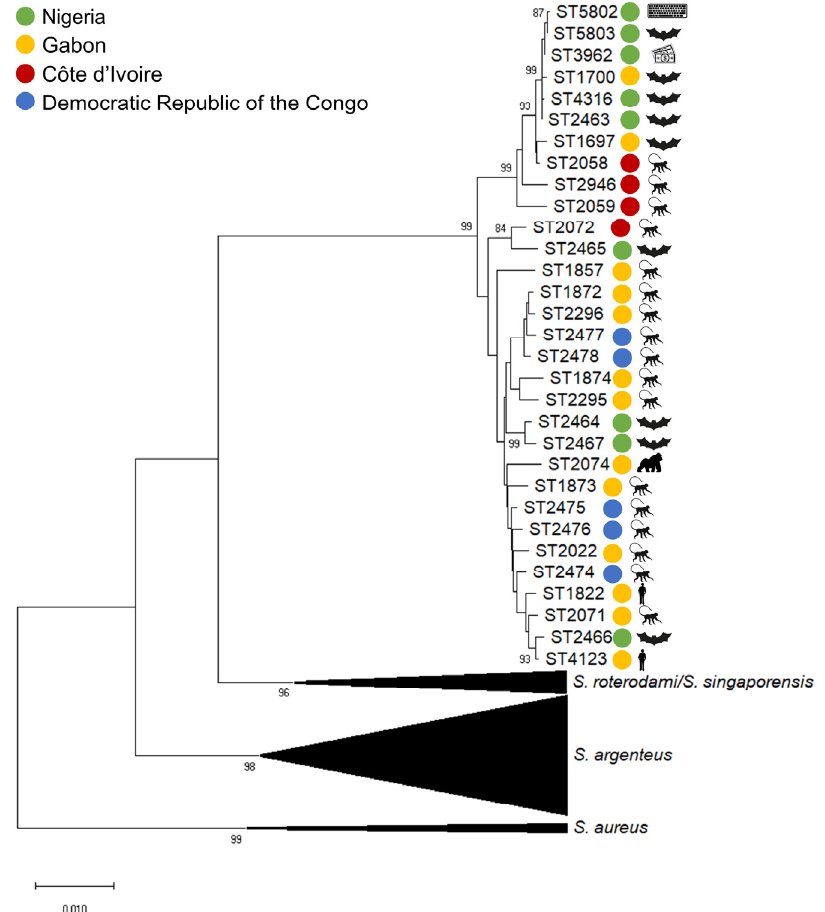
Figure 2. Phylogeny of Staphylococcus schweitzeri . The concatenated sequences of the seven alleles included in the multilocus sequence typing (MLST) scheme were used to construct a Neighbor-Joining tree for this review. The sequences were obtained from the PubMLST database (https://pubmlst.org/, accessed on 30 November 2021). The tree is rooted to the S. aureus sequence types (ST) ST5, ST22, ST30, ST45 and ST398 (collapsed). S. argenteus STs (collapsed) and S. roterodami / S. singaporensis ST were used as published elsewhere [3,5,6]. Only bootstrap values ≥ 80% were displayed. Sequencing of the 16s RNA gene can be used to delineate S. schweitzeri from other